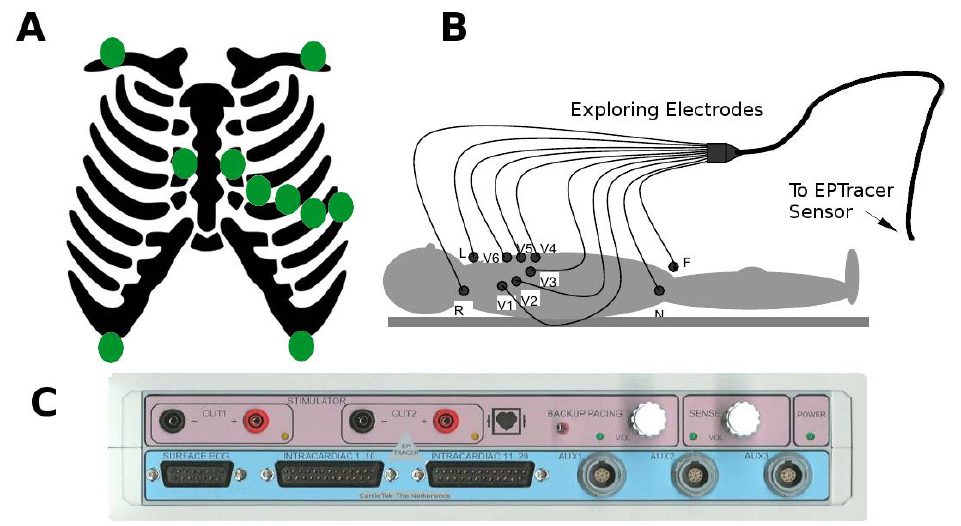
Figure 1. Electrocardiogram (ECG) recording and characteristics of the EPTracer sensor. ( A ) Schematic diagram representing the standard position of the exploring electrodes (green dots) on the body surface. ( B ) According to the position of the exploring electrodes on the body surface, and the configuration of pairs for computing differences in potential, the ECG signals receive standardized names. L, R, F, V1, V2, V3, V4, V5, and V6 constitute the differences in potential between the corresponding electrode and an indifferent electrode (central terminal of Wilson). In addition, three ECG signals are computed as the algebraic sum of potentials at different pairs of electrodes (lead I = L + R; lead II = R + F; Lead III = L + F). ( C ) EPTracer sensor front